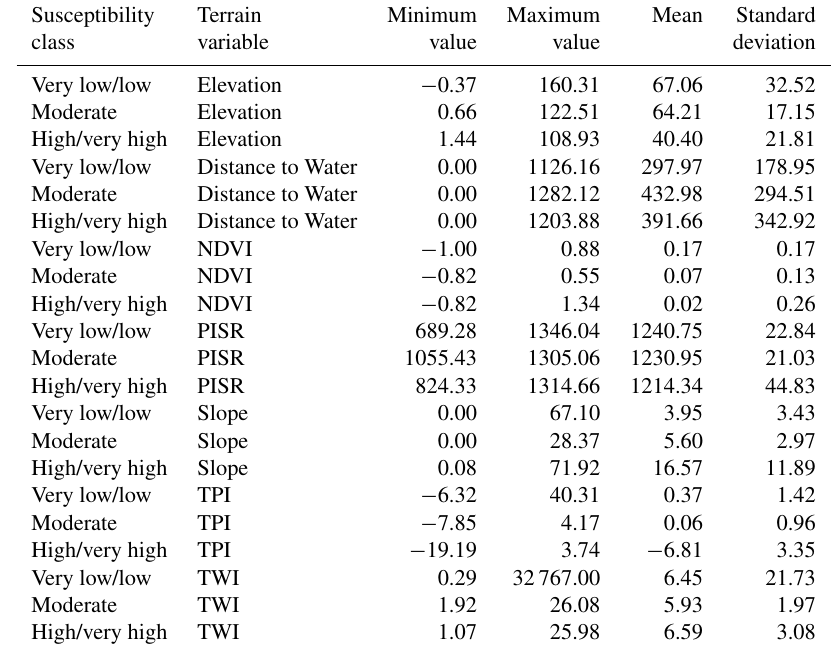
Table 4. Terrain values for areas of overlap between ALD and ME models. See units for each terrain variable in Table 2. Susceptibility Terrain Minimum Maximum Mean